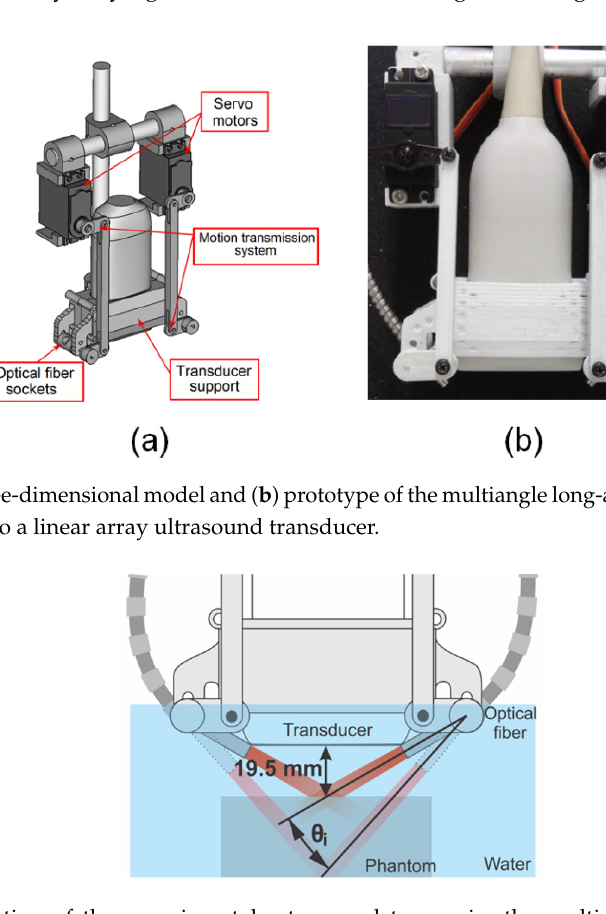
Table 1. Multiangle illumination and acquisition parameters.